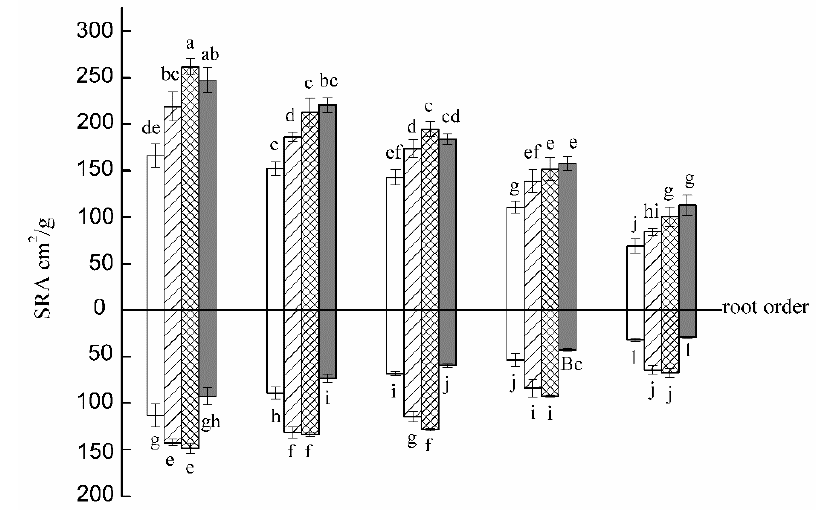
Figure 4. The effect of crop tree management on the RLD at different distances from the target Pinus massoniana . The X axis is the first to the fifth root order. The bars above the X axis represent the crop trees, and the bars below the X axis represent the noncrop trees. I, II, III, and IV represent the distance of fine roots to the target tree at 0–0.5, 0.5–1, 1–1.5, and 1.5–2 m. Each bar represents the mean ± SD with three replicates. Different letters above or below each bar indicate significant differences among groups compared by Fisher’s LSD test at p < 0.05.